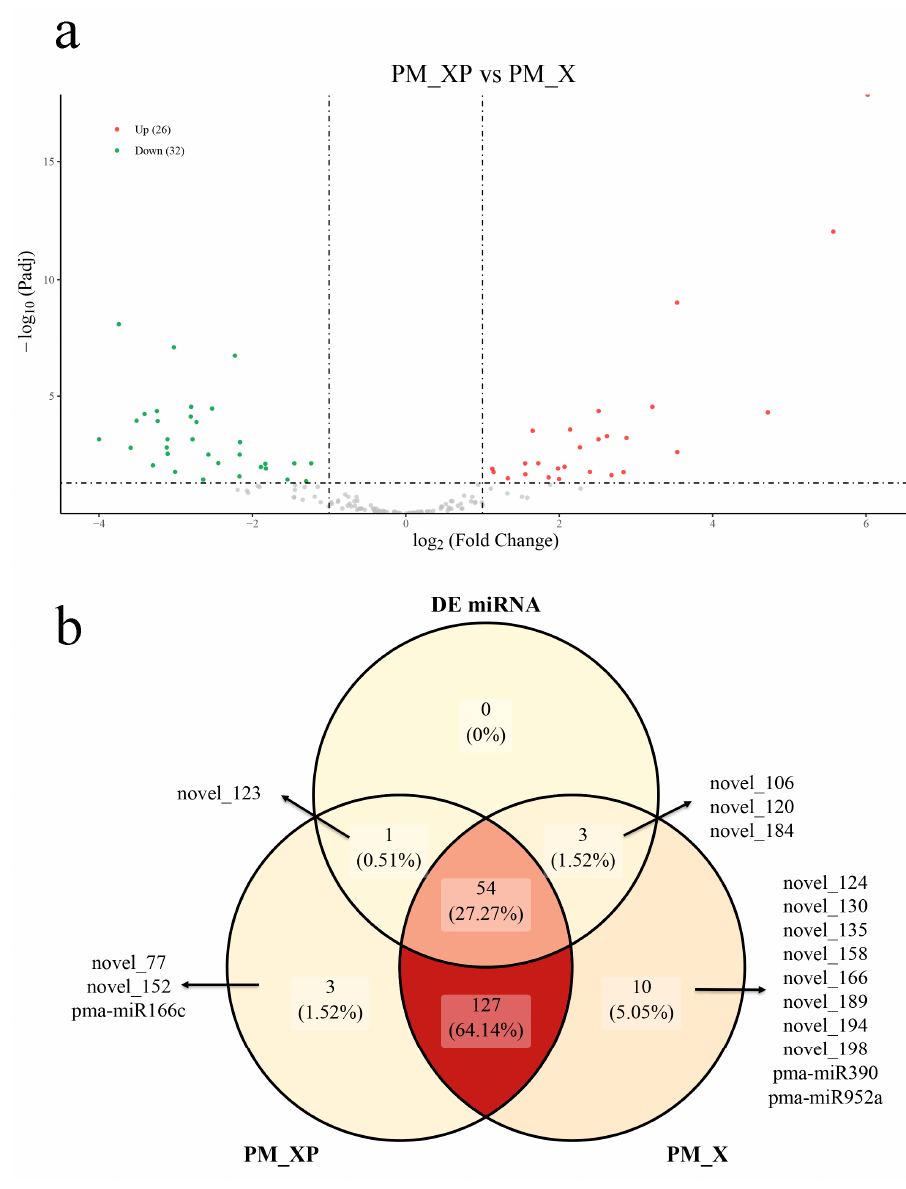
Figure 4. The differentially expressed miRNAs in developing xylem (PM_X) and protoplasts isolated from developing xylem (PM_XP). ( a ) Volcanic diagram of differentially expressed miRNAs. ( b ) Venn diagram of differentially expressed miRNAs.